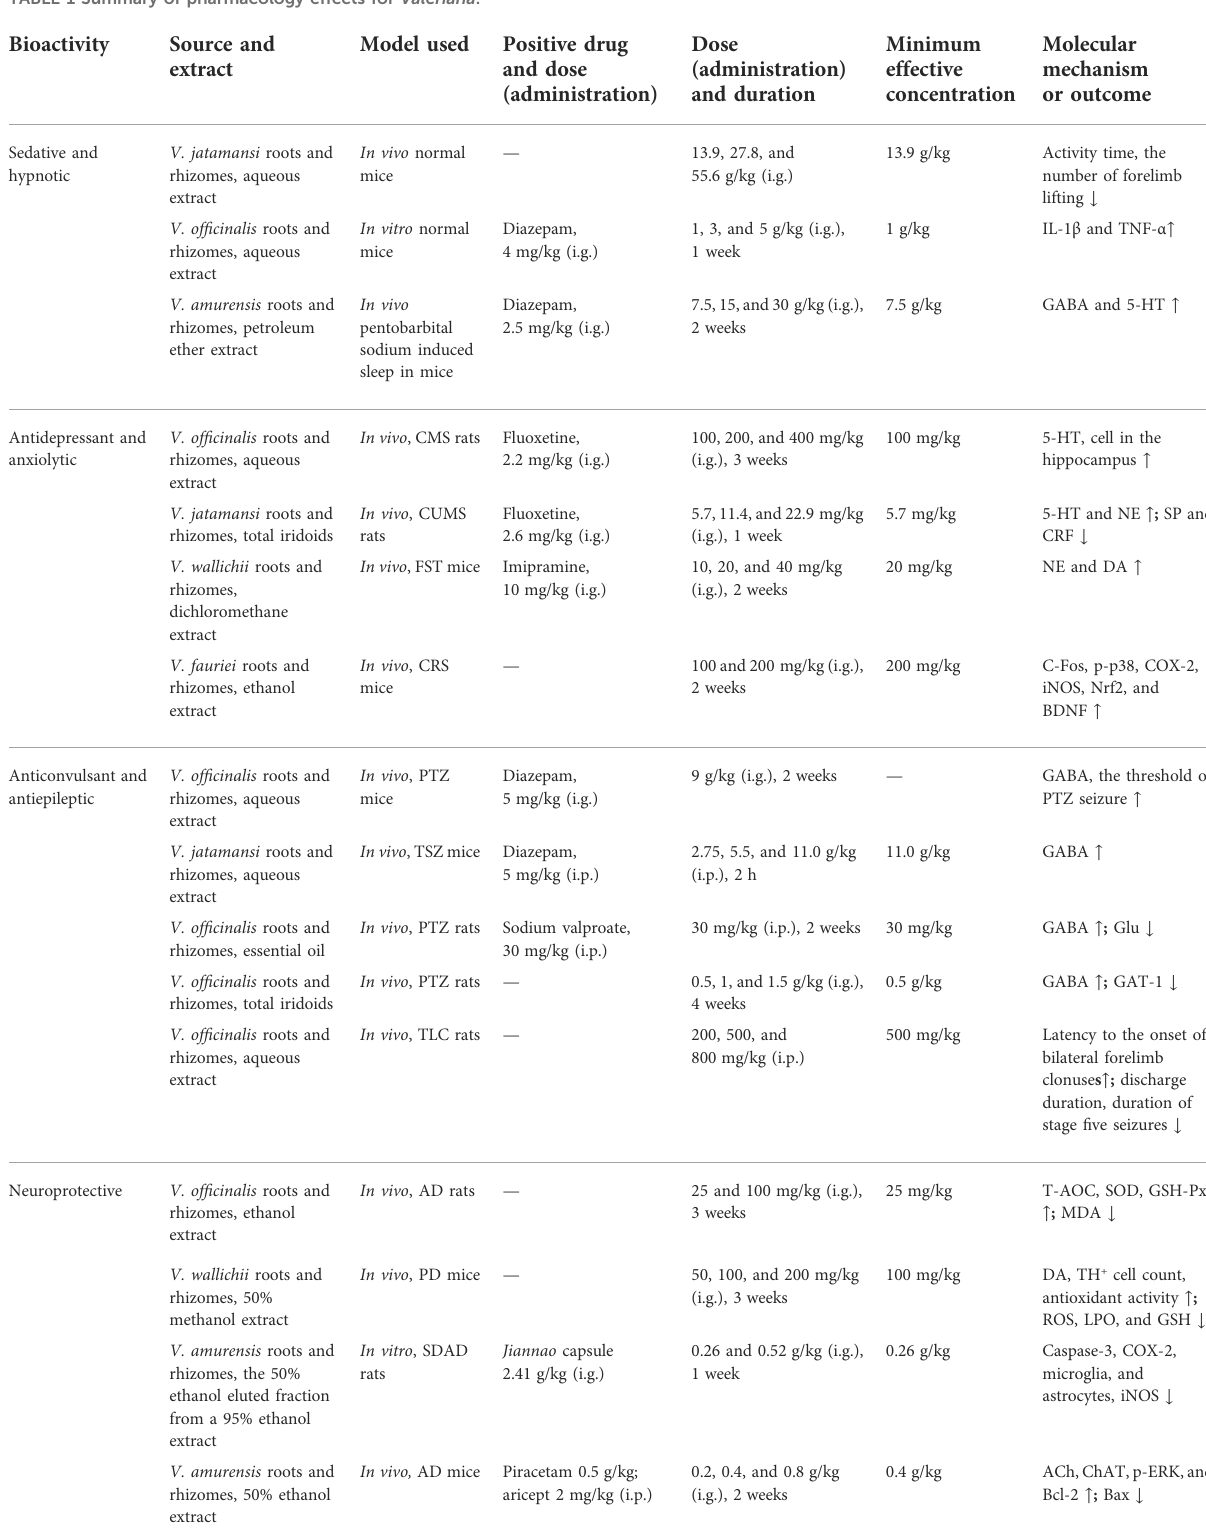
TABLE 1 Summary of pharmacology effects for Valeriana